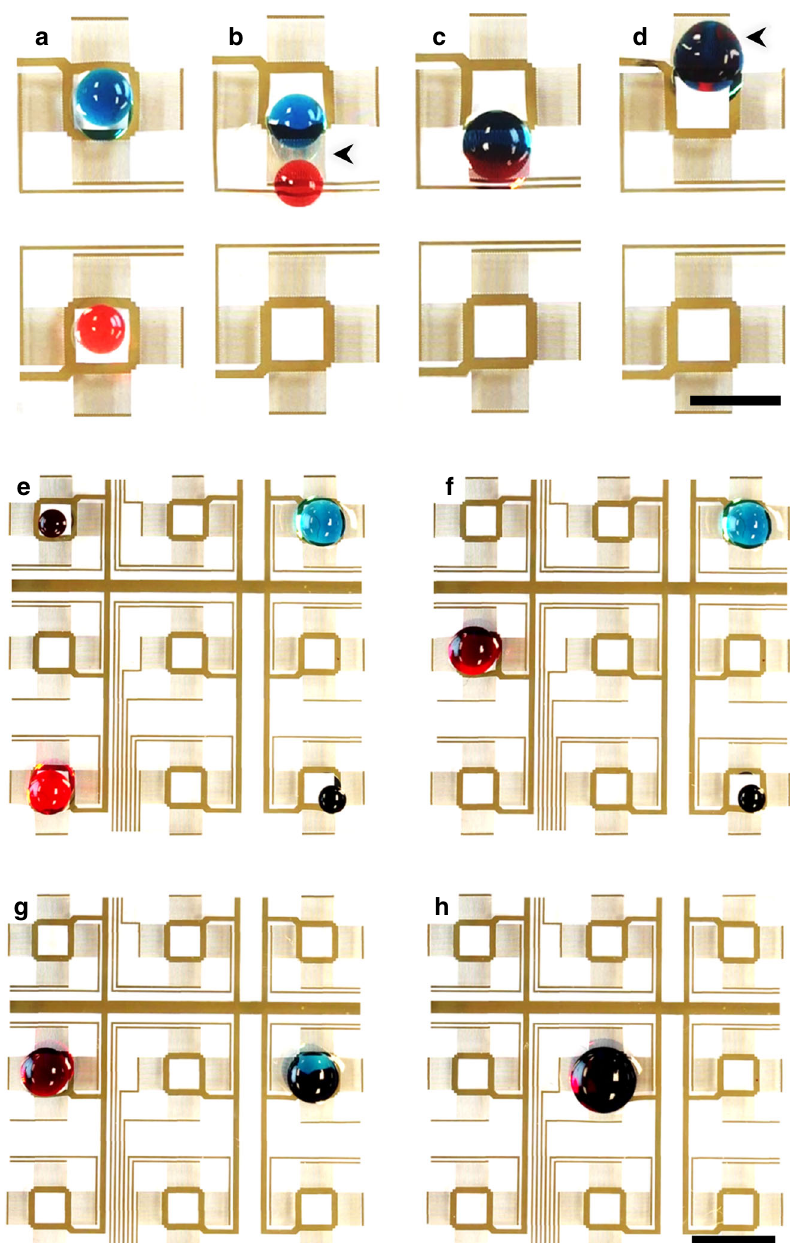
Fig. 6 Droplet merging using a digital acousto fl uidic device. a – d The merging process of two droplets. Scale bar: 5 mm. The black arrows indicate the activated transducers. Supplementary Movie 2 shows the complete merging process. e – h Two-stage sequential merging of four dye-containing droplets. The fi rst-stage brings the vertically aligned droplets together along the center line where they are then horizontally combined for the second-stage reaction at the center pixel. Scale bar: 8